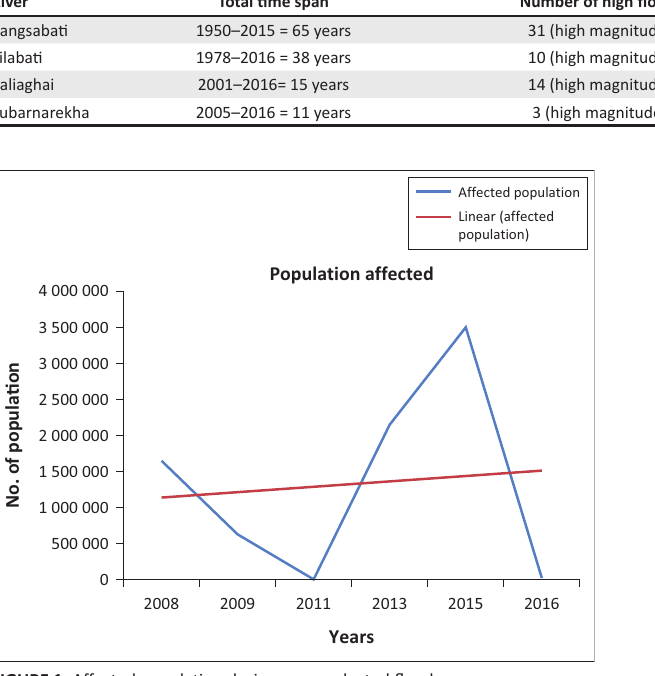
FIGURE 1: Affected population during some selected flood years.